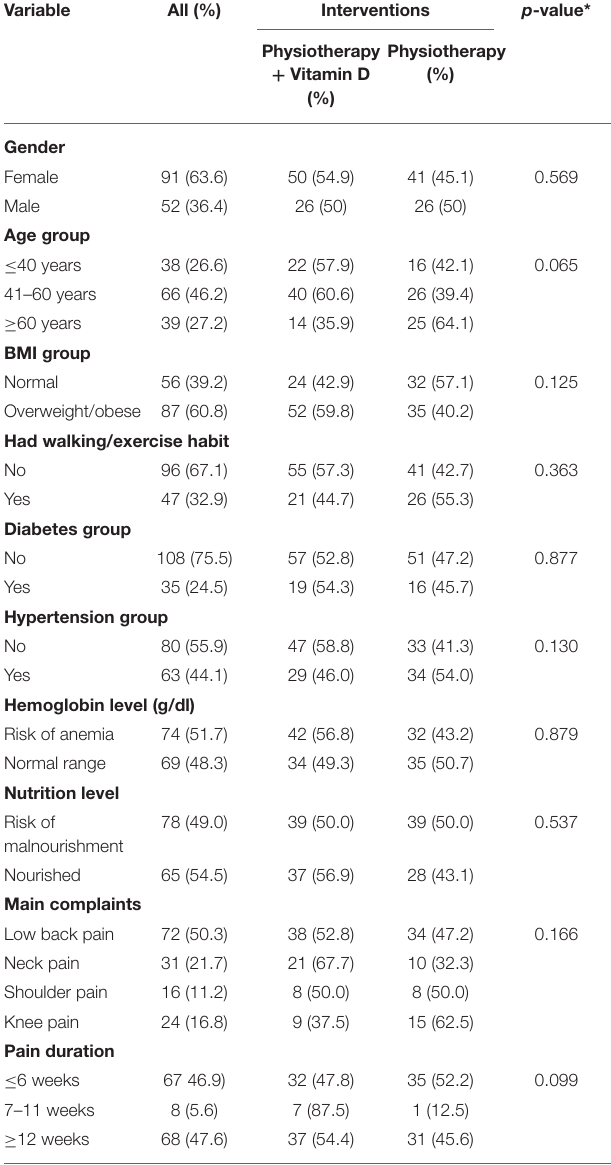
TABLE 1 | Baseline characteristics of the